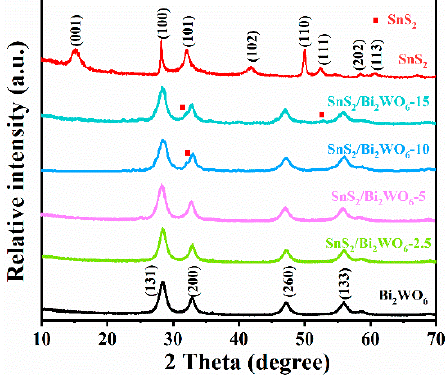
Figure 1. XRD patterns of prepared